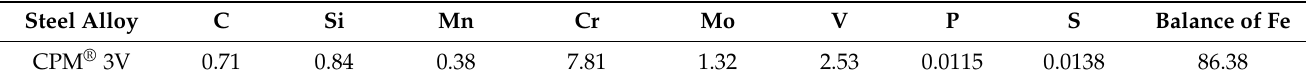
Table 1. Composition of CPM ® 3V tool steel from Arc/Spark-OES bulk composition analysis (all numerical values given in